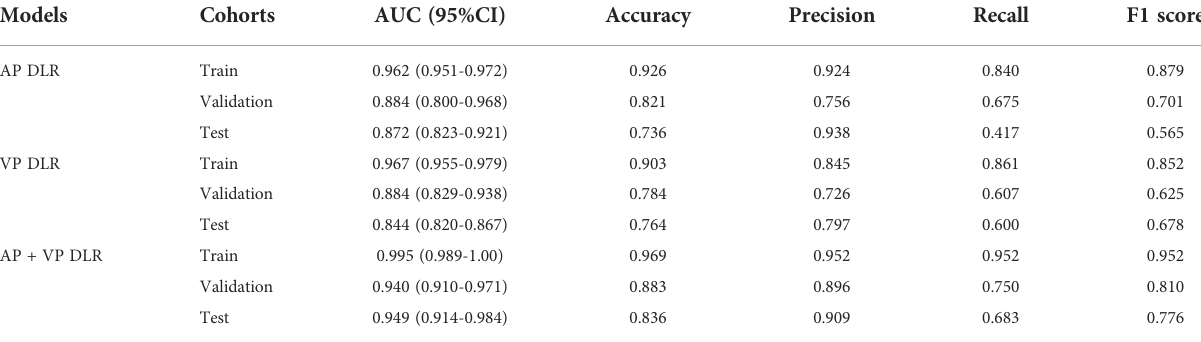
TABLE 3 The performance of different CNN